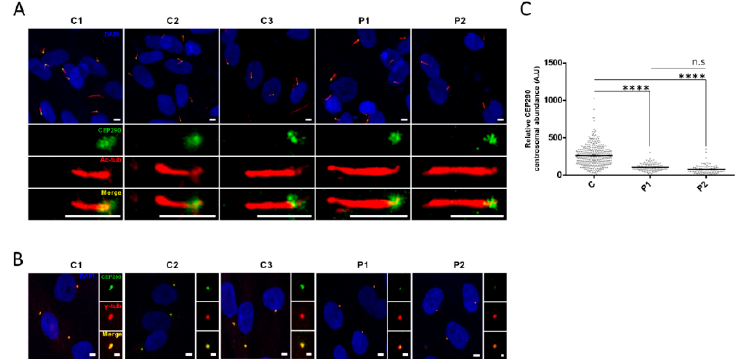
Figure 3. CEP290 expression assessment in quiescent cells. ( A ) Representative images of CEP290 (green) localization in quiescent control and mutant fibroblasts. Acetylated α -tubulin (Ac-tub; red) is used to stain the ciliary axoneme. As in control cell lines (C1–C3), CEP290 is correctly localized at the base of the cilia in patient (P1 and P2) fibroblasts. Scale bar, 5 µ m. ( B ) Centrosomal localization of CEP290 (green) in control and mutant fibroblasts. The γ -tubulin ( γ -tub; red) labeling is used as a centrosomal marker. Image scale bar, 5 µ m and inset scale bar, 2 µ m. ( C ) Quantification of the CEP290 immunofluorescence intensity at the basal body in each cell line (C represents the pooled values of C1–C3). Each dot depicts the labeling intensity of the protein in individual cells from six microscope fields (recorded automatically). The solid line indicates the mean. **** p ≤ 0.0001, n.s = not significant. A.U. = arbitrary unit.